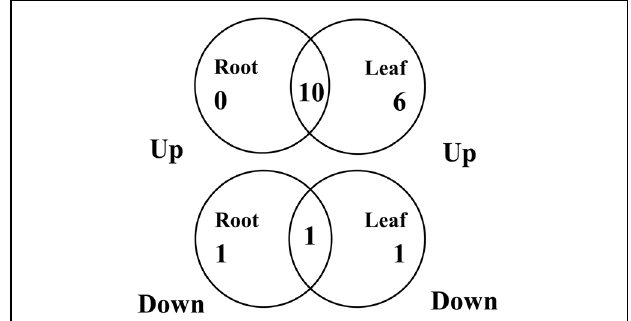
FIGURE 3 | Venn diagram analysis of expression of 19 selected CaNAC genes in roots and leaves of ILC482 under dehydration. CaNAC24 was not included in the analysis because it displayed opposite expression patterns in dehydrated ILC482 leaf tissues at 2 and 5